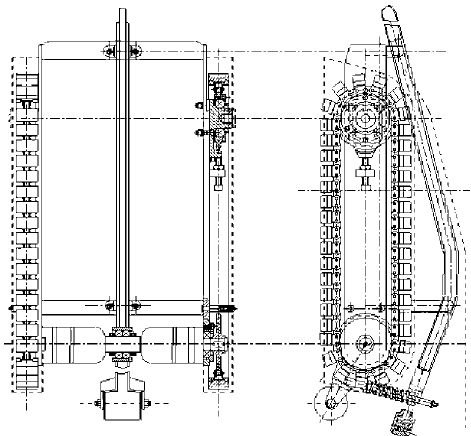
Figure 2 Mechanical architecture of the robot.